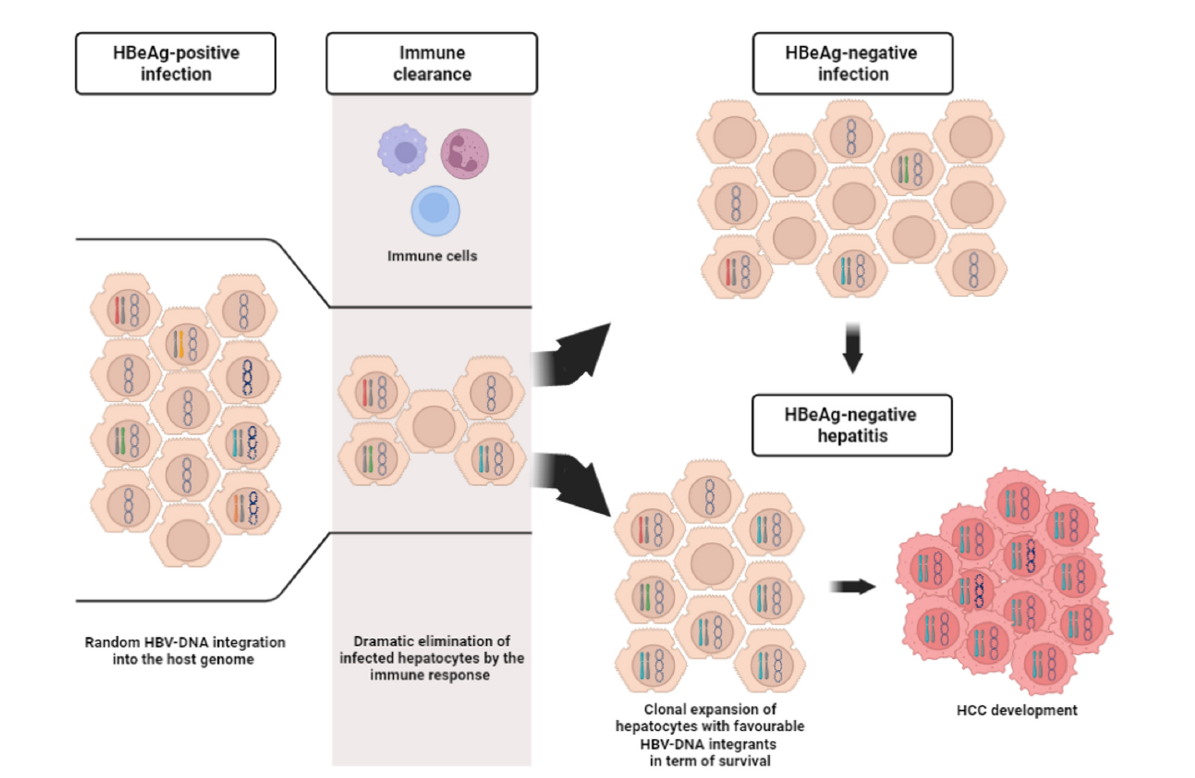
FIGURE2 Description of the course of hepatocytes during chronic HBV infection. HBeAg-positive infection is characterized by a huge number of infected hepatocytes, as a consequence of high viral replication levels. The infected hepatocytes can harbor only cccDNA inside the nucleus (represented by the circular molecule) or also HBV-DNA randomly integrated into the host genome (represented by differently colored chromosomes). Not infected hepatocytes are indicated by cells with empty nucleus. Immune responses (depicted by the three different cells at the top of the gray stripe) reduce the number of the infected hepatocytes. From this stage the infection can run into two different outcomes. The former is represented by HBeAg-negative infection, where the pool of infected hepatocytes (with/without HBV-DNA integrants) remains limited, while the latter is represented HBeAg-negative hepatitis. In this stage, the immune response can induce the clonal selection and expansion of infected hepatocytes with favorable HBV-DNA integrants in term of survival. This process can hesitate in HCC